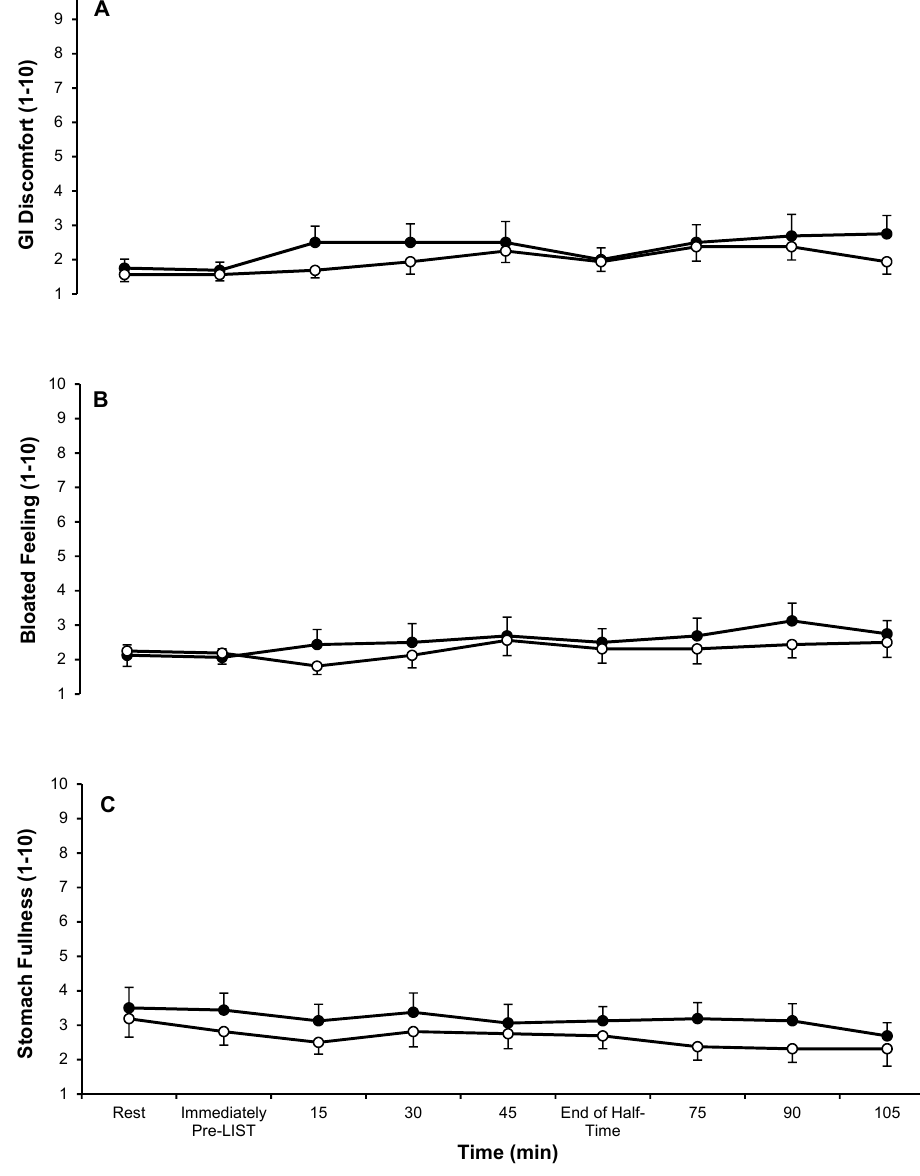
Figure 4. Subjective feelings questionnaires for ( A ) GI discomfort; ( B ) bloated feeling and ( C ) stomach fullness (A, B, C: 1 = not at all; 10 = very, very much) during CHO ( ) and PLA ( mean ± SE. GI discomfort: gastrointestinal discomfort; CHO: carbohydrate trial; PLA placebo